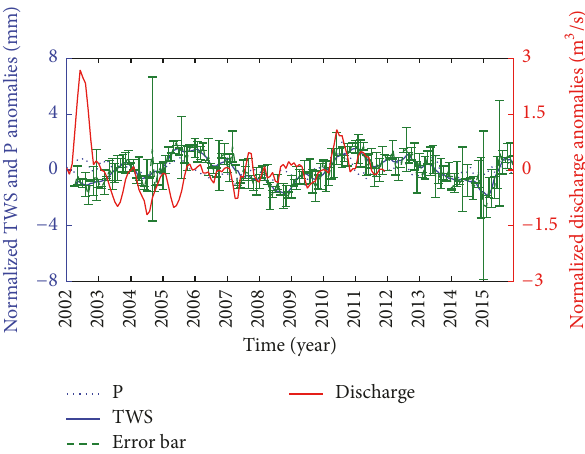
Figure 4: Time series of nonseasonal variations in TWSA, mean discharge, and precipitation in the TRB. The error bars indicate the uncertainties of GRACE